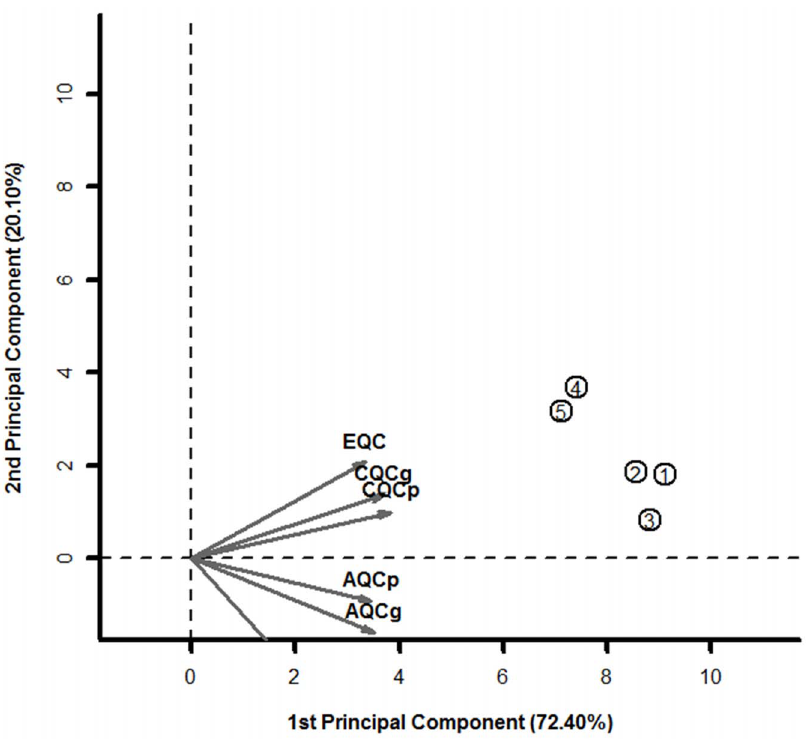
Figure 1. PCA biplot numbers on PCA biplot represents studies in Table 1. Study number placed opposite to quality measure axes are of low quality and should be excluded. No outlier study was detected.